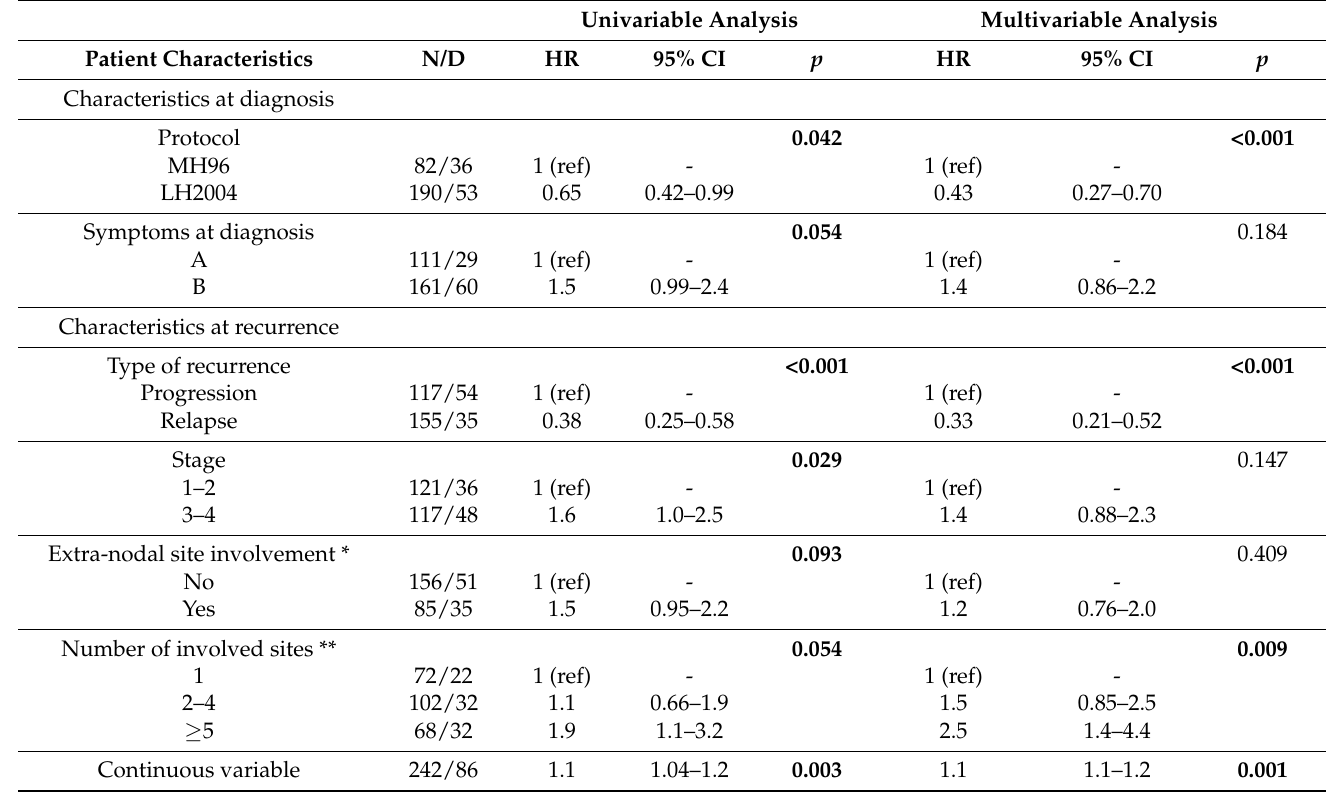
Multivariable analysis (Table 8) confirmed a higher OS for patients treated with LH2004 protocol (HR = 0.43) and a lower OS for those with progressive disease (HR = 0.33) and with a high number of involved sites at recurrence (HR = 2.5 for ≥ 5 involved sites) Table 8. Univariable and multivariable Cox regression model to assess the overall survival after recurrence by characteristics at diagnosis and at relapse/progression of 272 patients with classical Hodgkin’s